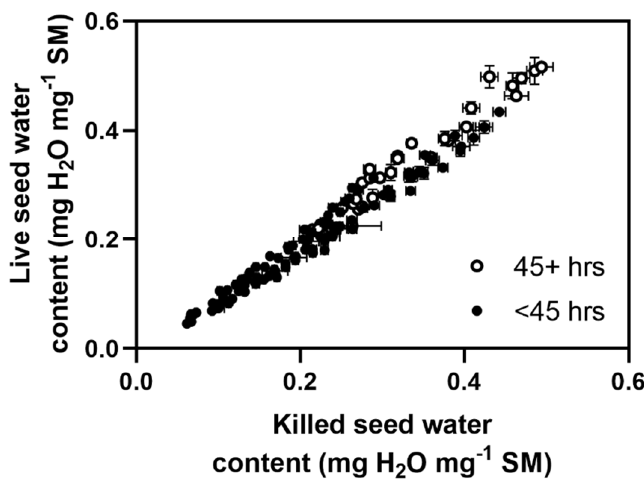
Figure 2. Water content of live vs seeds killed with a hot needle. Filled circles represent measurements of seeds within the first 45 h of incubation, while opened circles represent measurements made after 45 h. Error bars represent standard errors.